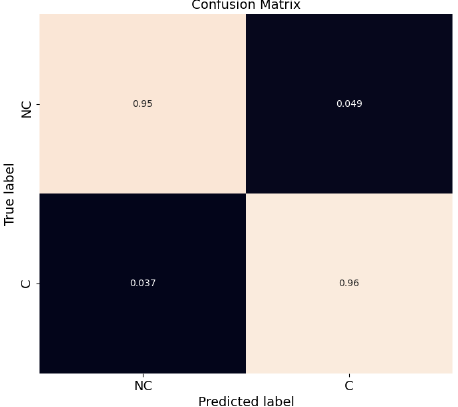
Figure 7. Confusion matrix for RF classification for all samples at recording #18.